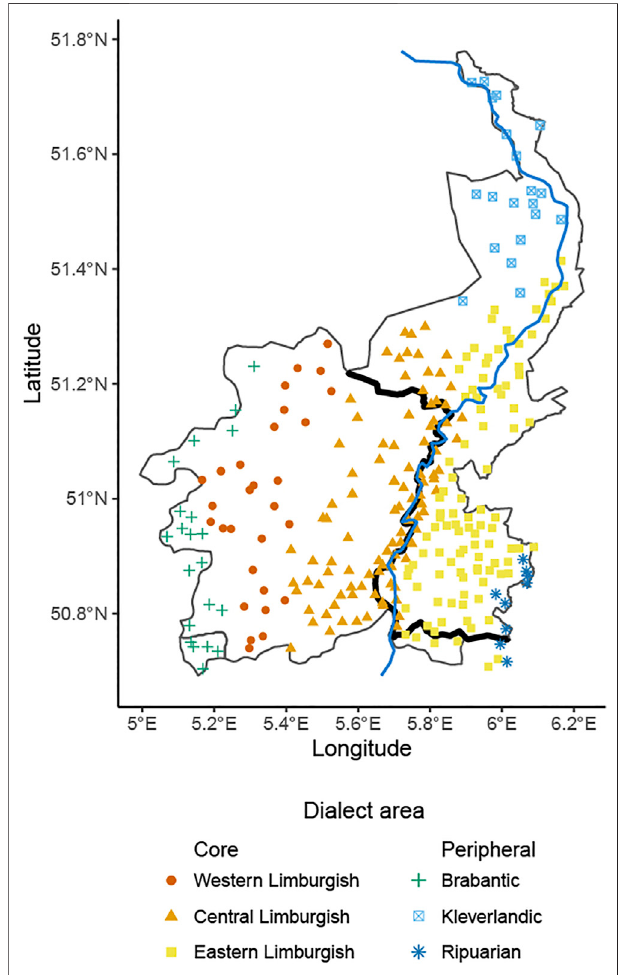
FIGURE 2 | Map of locations included in the database, with their classi fi cation into one of six dialect areas.